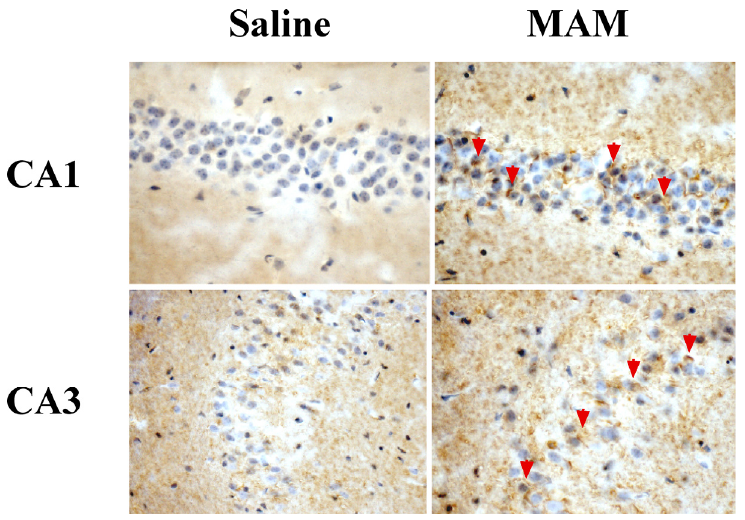
Figure 11. MAM induces Tau phosphorylation in the brain of htau mice. Neonatal (PND3) htau mice (mouse mutant that overexpresses normal human Tau) were given a single subcutaneous injection of saline or MAM (22 mg/kg). The hippocampus of the offspring was examined at post-natal day 90 for the phosphorylation of Tau at serine 199 (pS199). Note the heavy accumulation of pS199 within the axons ( arrowheads ) of CA1 and CA3 pyramidal neurons after MAM